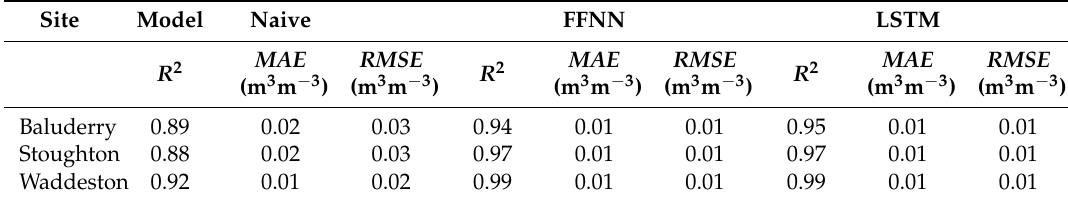
Table 6. Prediction performance of the non-machine learning (naïve) and neural network models when tested on the evaluation dataset for all the model training